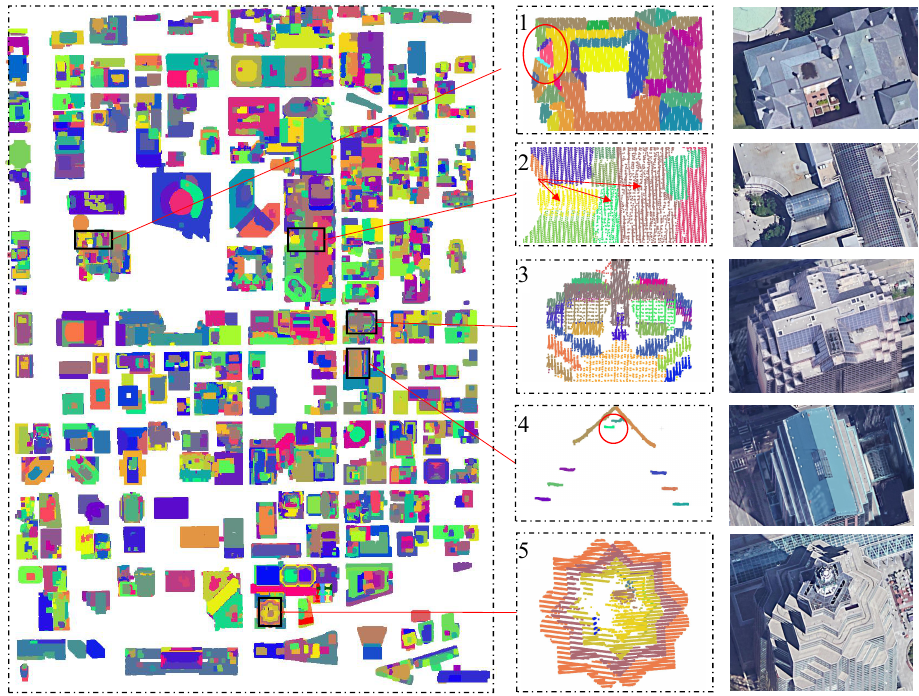
Figure 6. Overall segmentation results. From left to right: segmentation results, enlarged details, and corresponding Google